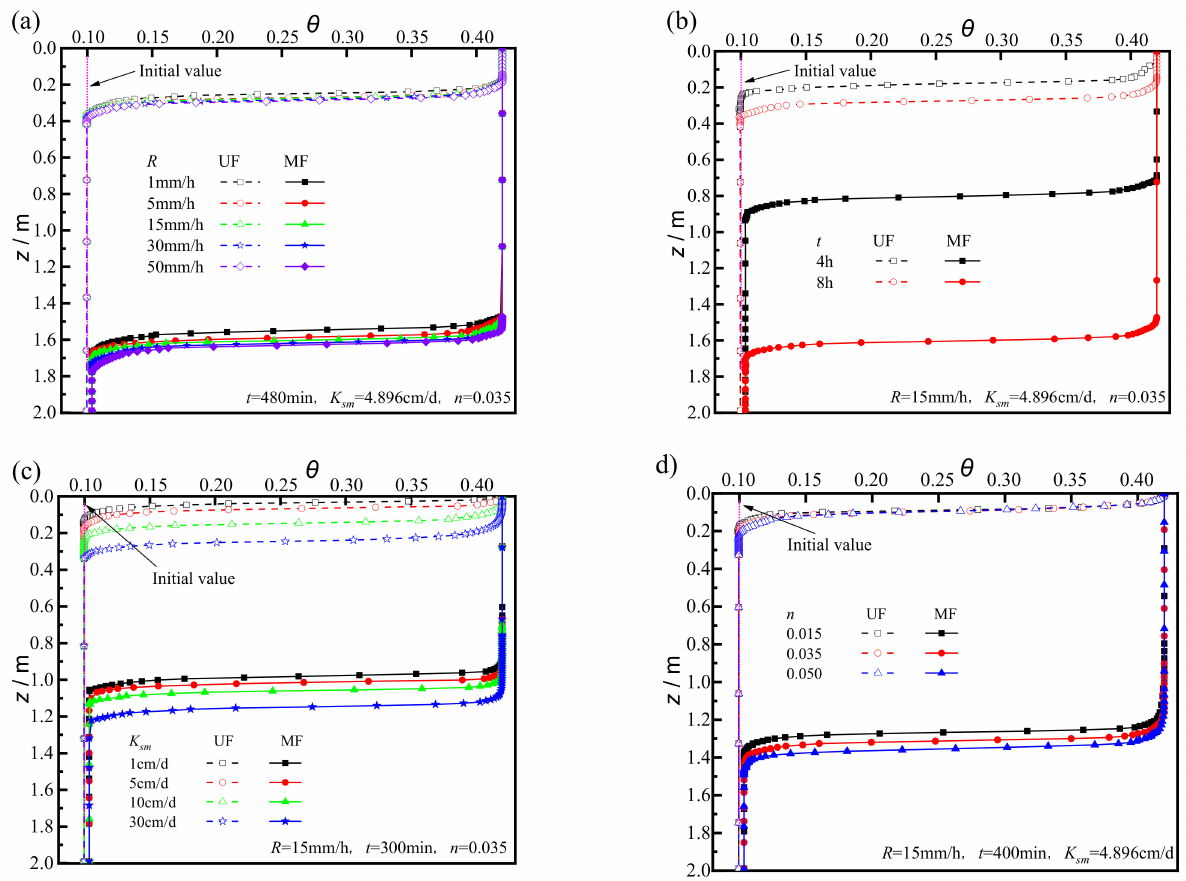
Figure 10. The influence of different factors on water content: ( a ) Rainfall intensity, R ; ( b ) Rainfall duration, t ; ( c ) Saturated conductivity, K sm ; ( d ) Roughness coefficient, n